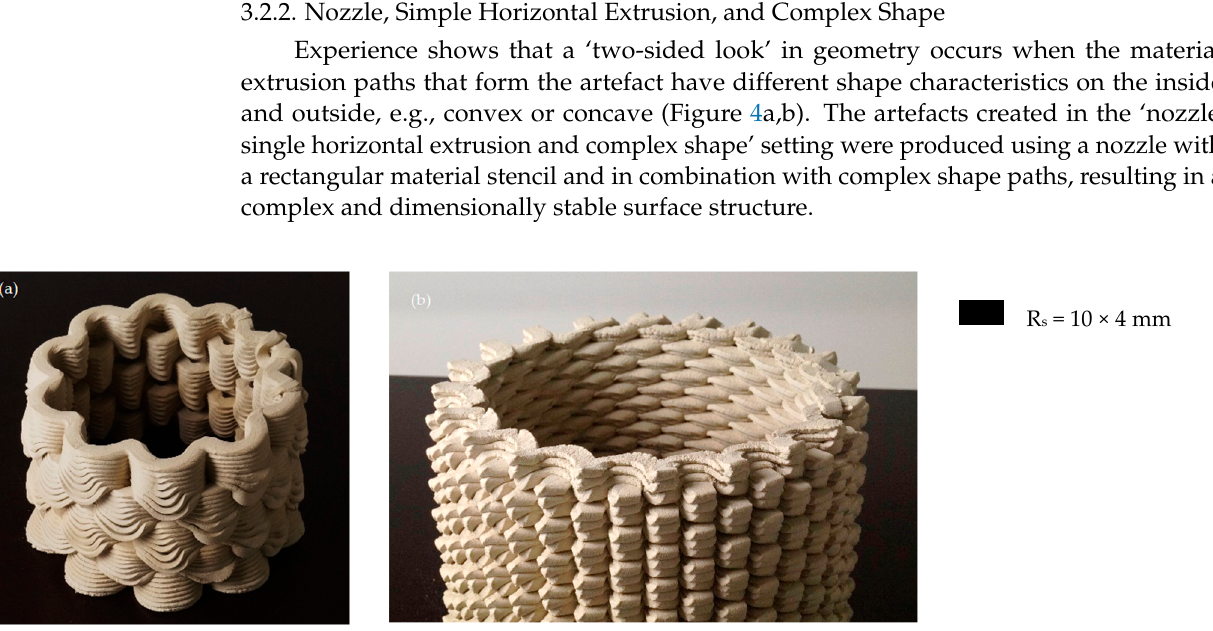
Figure 4. Comparison of the shape characteristics of convex ( a ) and concave ( b ) gradients in the LDM of clay.